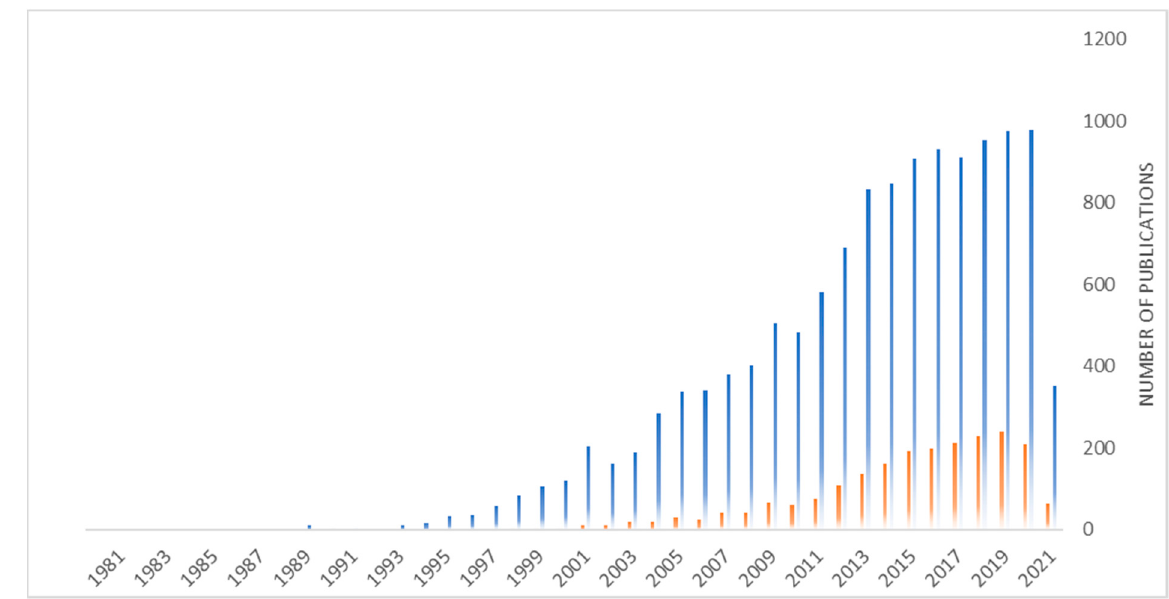
Figure 2. Evolution of the number of publications related to molecularly imprinted polymers (blue) and the combination of molecularly imprinted polymers and any of the following keyword: hybrids, nanocomposites, gold, silver, iron, silica, quantum dots, carbon dots (orange). Data extracted from 1findr.1science.com the 20 April 2021 .